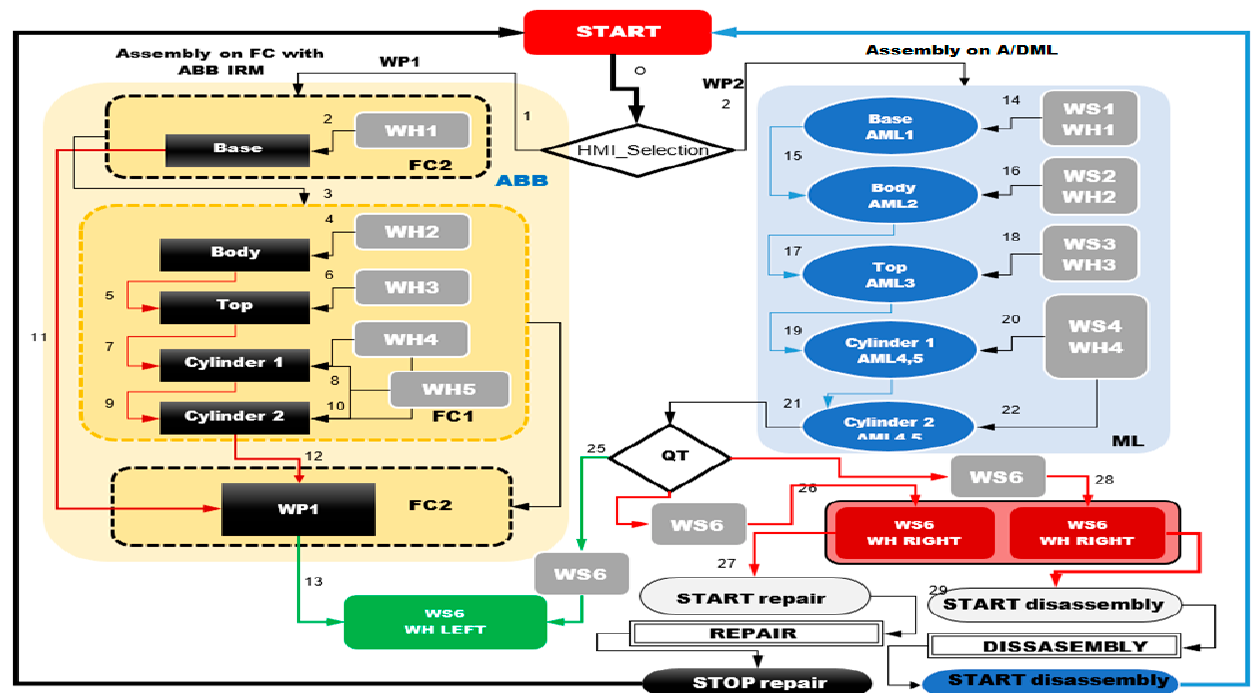
Figure 9. Task scheduling for assembly functionality.